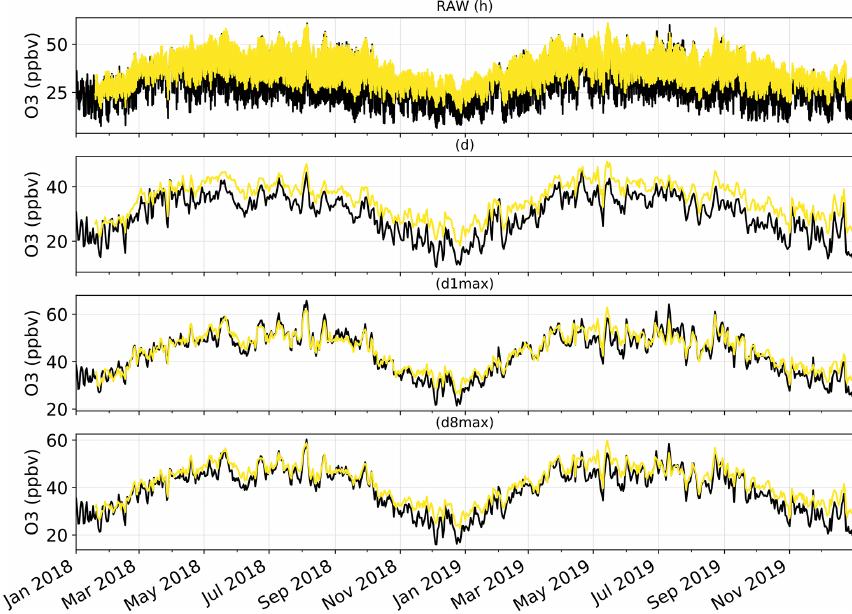
Figure 2. Time series of the mean O 3 mixing ratios over the Iberian Peninsula, as observed by monitoring stations (in black) and as simulated by the raw CAMS regional ensemble D + 1 forecasts (in yellow). Time series are shown at the hourly (h) , daily mean (d) , daily 1h maximum (d1max) and daily 8h maximum (d8max) timescales. O 3 mixing ratios are averaged over all surface stations of the